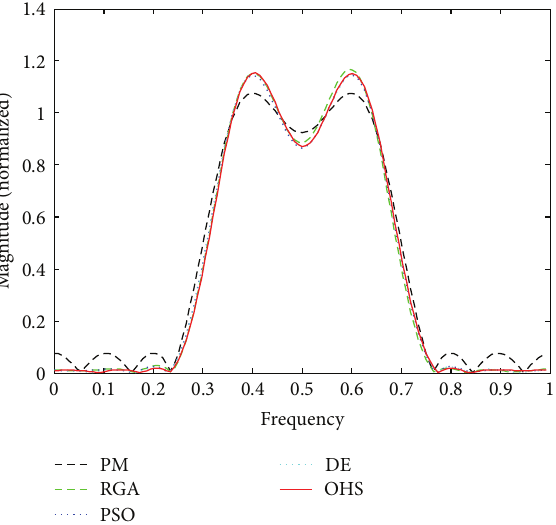
Figure 8: Normalized stop band ripple plots for the FIR HP filter of order 20.